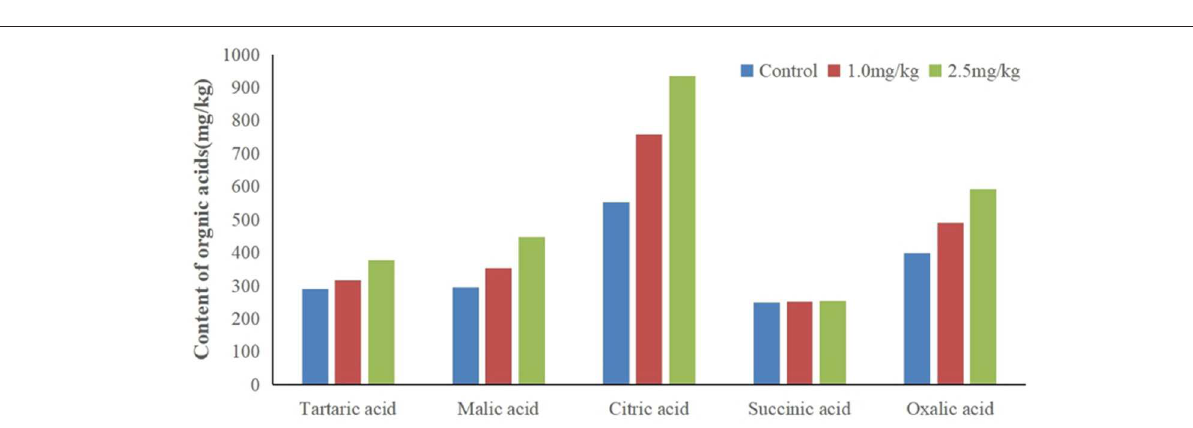
FIGURE 4 | Sixteen up-regulated amino acids in root exudates in response to exposure at 1.0 and 2.5 mg/kg Cd.